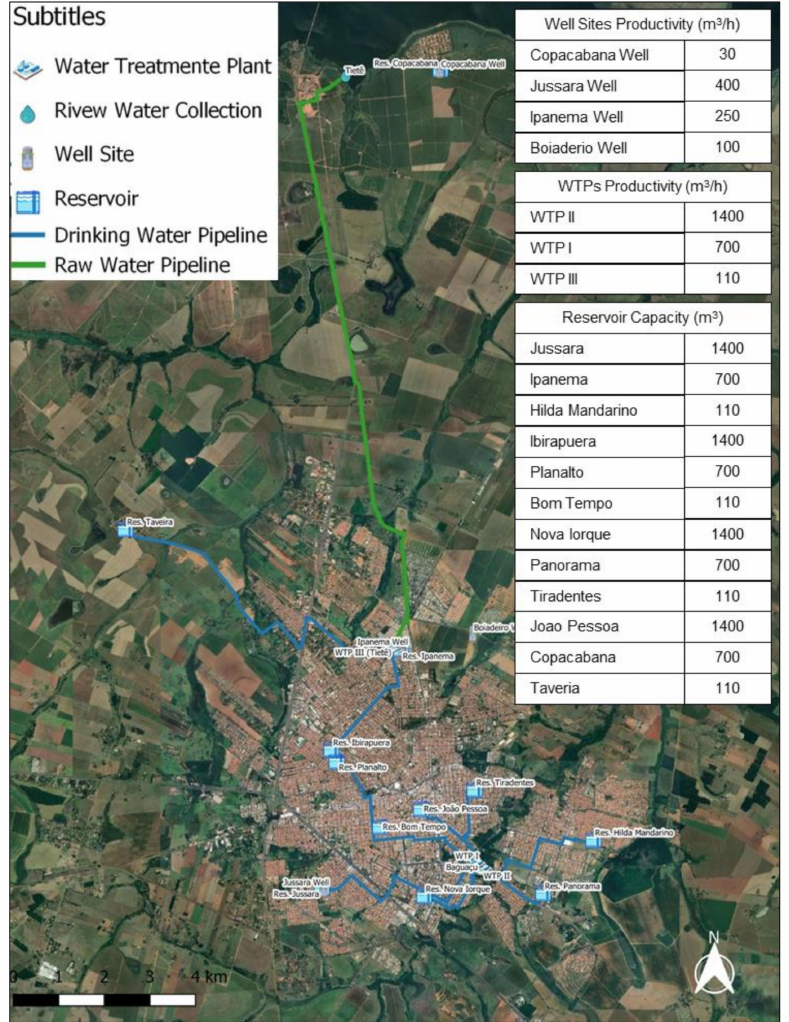
Figure 1. Water supply system in Aracatuba,